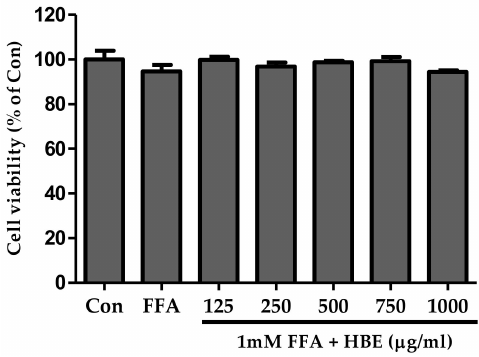
Figure 2. Effect of Honeyberry extract (HBE) on the viability of HepG2 cells. HepG2 cells were incubated in the various concentration of HBE with 1 mM free fatty acids (FFA) for 24 h. All experiments were repeated at least three times and data represent means ±